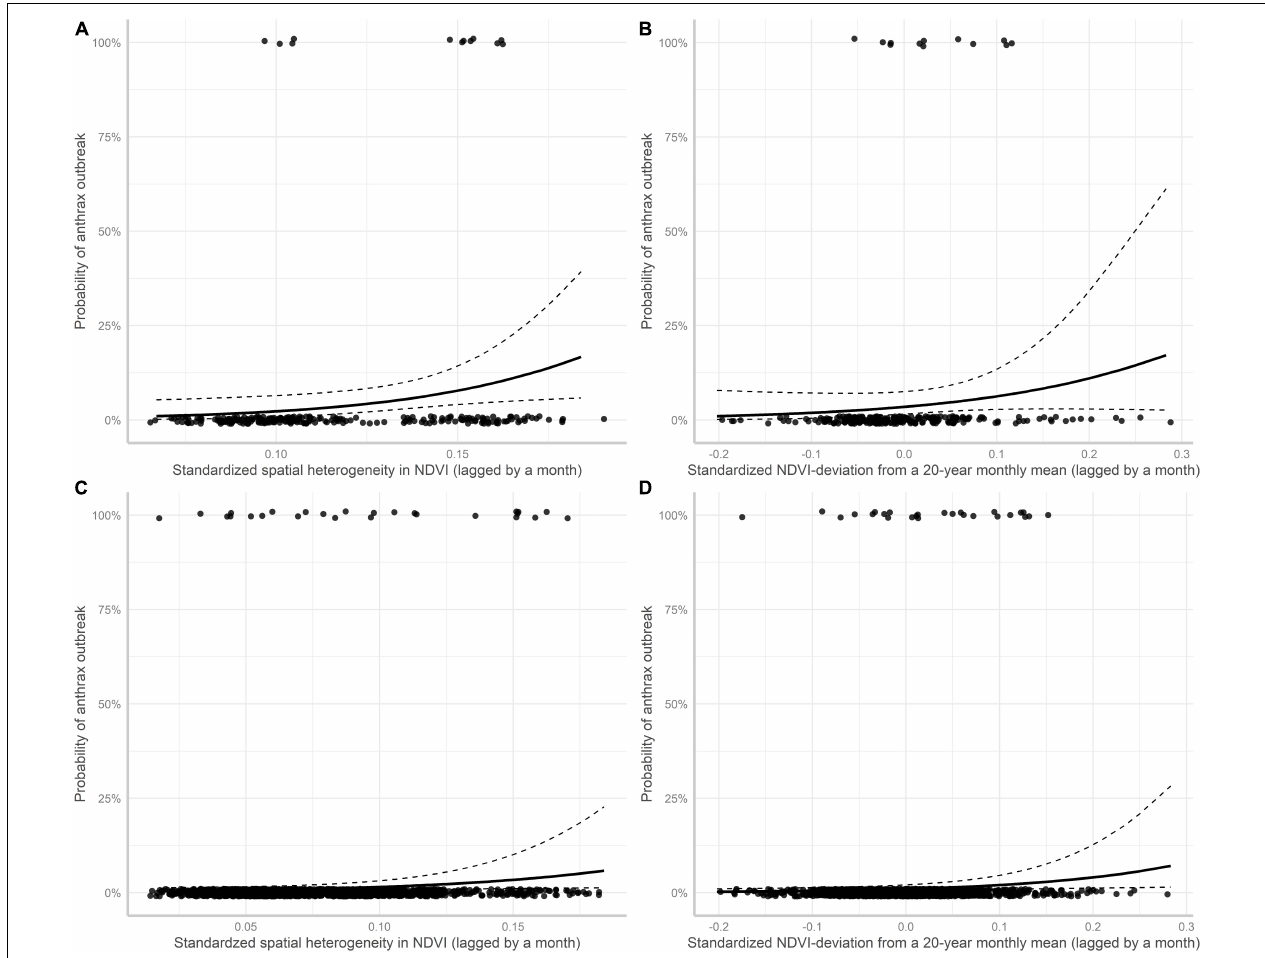
FIGURE 3 | The influence of NDVI metrics on the probability of monthly anthrax mortality in Lake Nakuru NP (A,B) and combined focal wildlife areas (C,D) . The predicted values and their confidence intervals are from a GLM (A,B) , and GLMM (C,D) binomial regressions